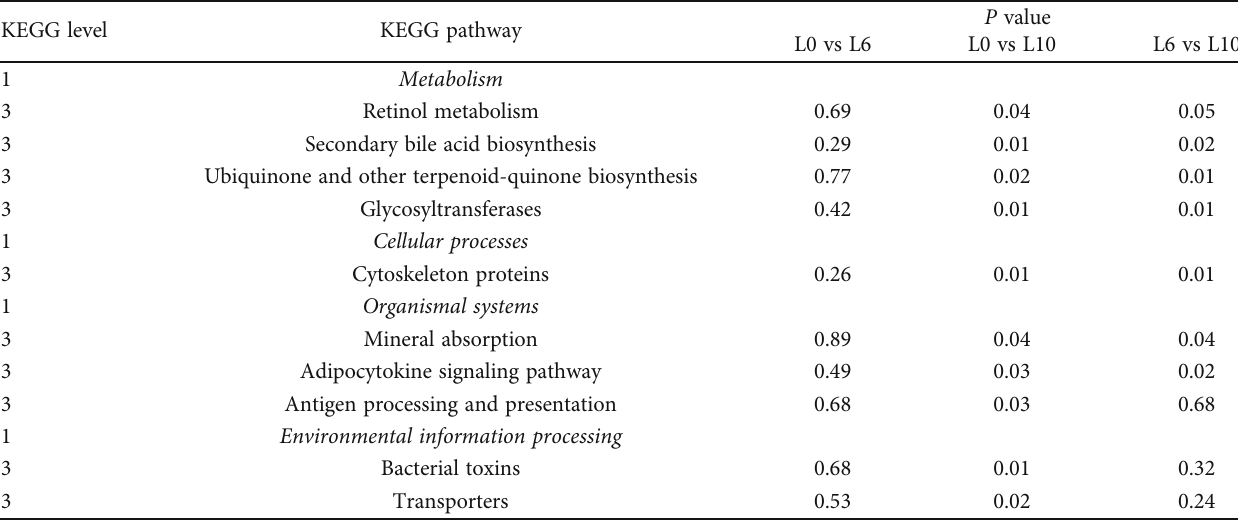
P < 0 : 05 indicated a signi fi cant di ff erence.